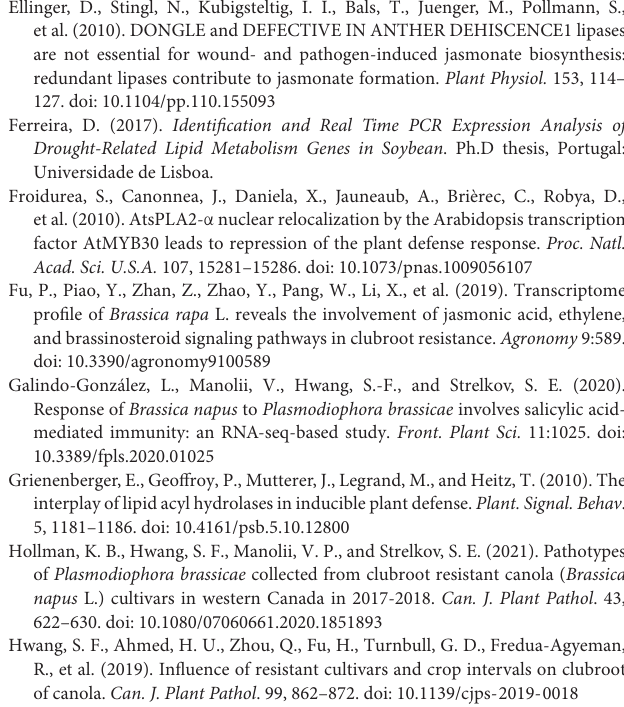
Supplementary Figure 1 | Phylogenic relationships of the 29 Arabidopsis PLAs and their homologs in Brassica species ( B. rapa , B. oleracea, and B. napus ). The homologs were identified by blasting Arabidopsis peptide sequences against Brassica peptide sequences using the BLASTP tool ( E -value ≤ 1e–10, coverage > 60%, identity > 60%, and the top 20 hits). The phylogenic tree was constructed with fasttree using PLA peptide sequences aligned by MUSCEL in Mega7. Arabidopsis WKRY2 (AT5G56270) was used as the root. Each PLA encoding gene in B. rapa was followed with an Arabidopsis gene ID in the genome annotation, which was kept in the phylogenic tree to confirm the clustering of the PLAs. Supplementary Figure 2 | Expression changes of BnPLAs in resistant and susceptible Brassica napus following Plasmodiophora brassicae inoculation. (A) The expression changes of plants in response to P. brassicae pathotype 3A (Zhou et al., 2020b). (B) The expression changes of plants in response to P. brassicae pathotype 5X (Galindo-González et al.,